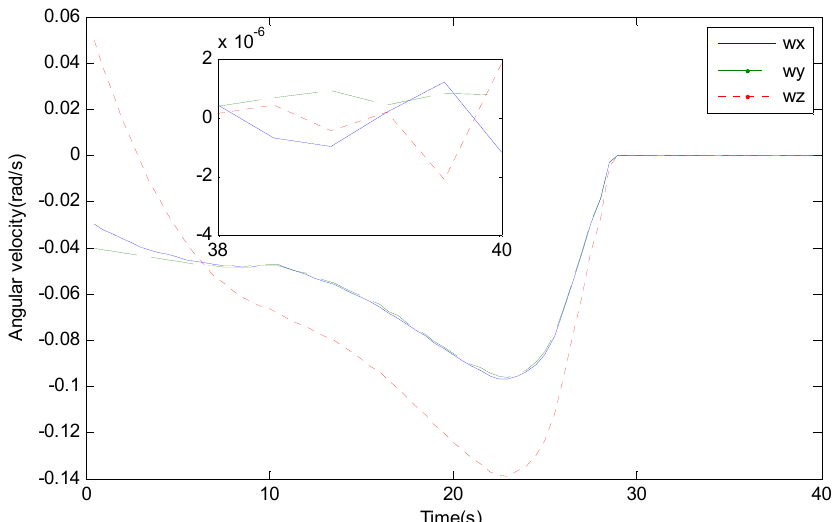
Figure 5. Curve of angular velocity.